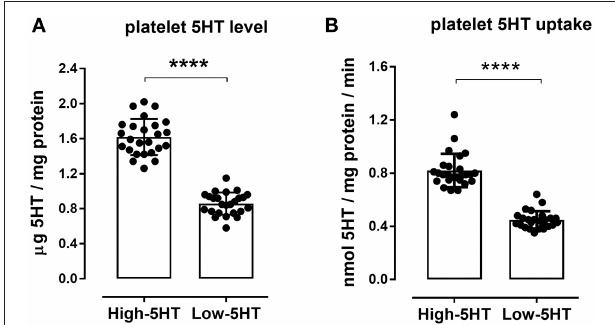
FIGURE 2 | Platelet serotonin parameters in high-5HT and low-5HT animals included in the experiments. (A) Platelet 5HT level and (B) velocity of platelet 5HT uptake, relative to platelet protein levels, were measured as described in the Methods section. Individual values and bars representing means ± SD of 25 animals per subline are shown. Values of 5HT level were 1.62 ± 0.21 and 0.86 ± 0.13, and of 5HT uptake velocity were 0.82 ± 0.13 and 0.45 ± 0.06, for high-5HT and low-5HT rats, respectively. p -values obtained with Student t -test. Values of both parameters in unselected animals are intermediate to those of the sublines. **** p <